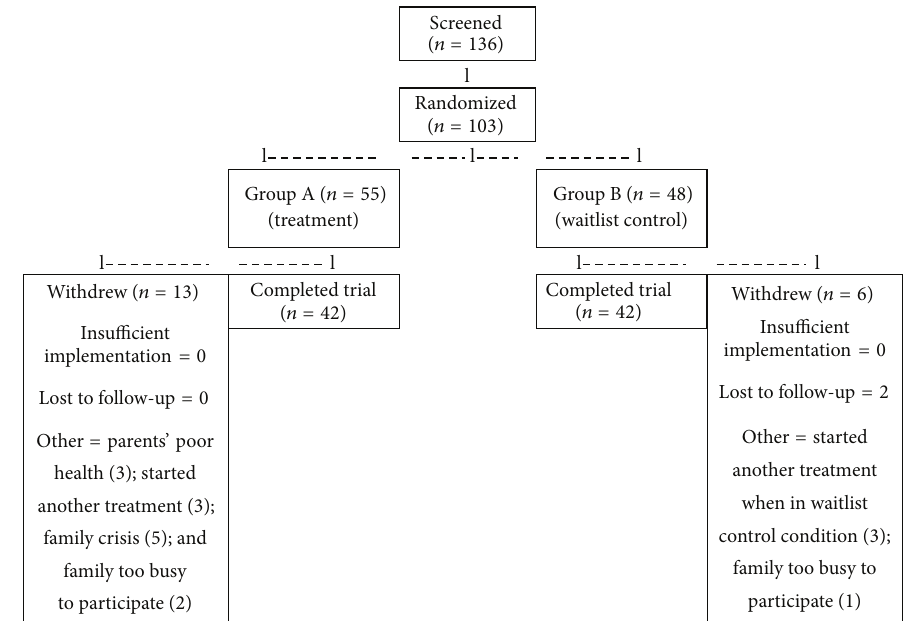
Figure 1: Participant flow